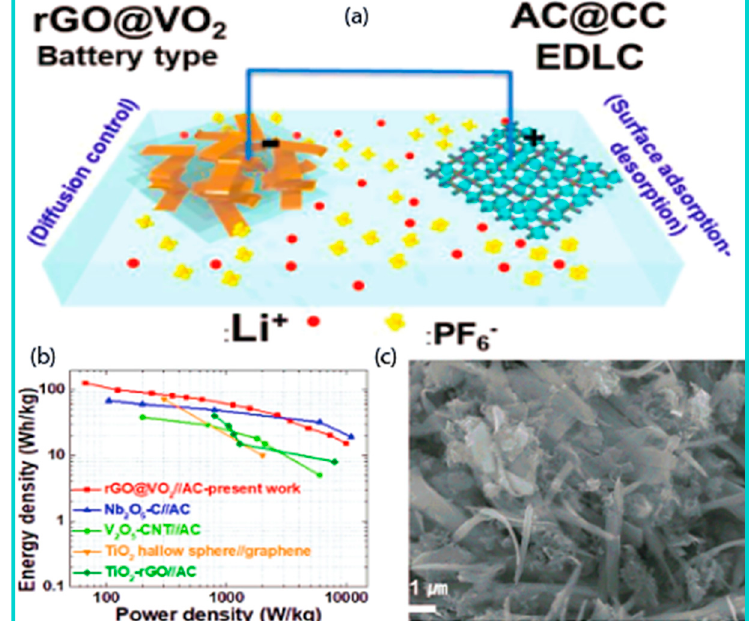
Figure 16. Schematic illustration of the as-fabricated battery − supercapacitor hybrid (BSH) device. ( a ) Comparative Ragone plot of the various stated hybrid storage devices with the as-fabricated BSH. ( b ) The FESEM of the rGO@VO 2 composite. ( c ) Reprinted with permission from [80], Copyright 2019, American Chemical Society.